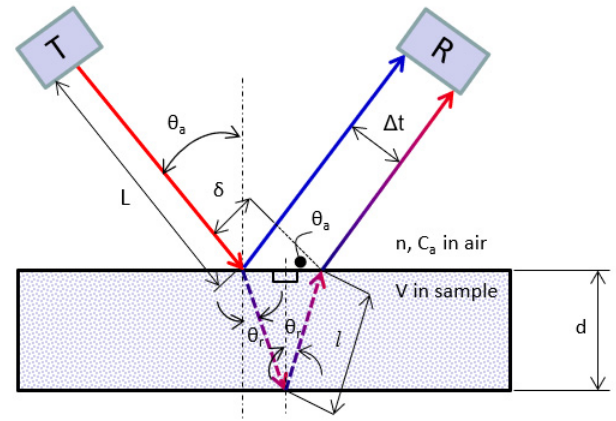
Figure 1. Diagram showing the geometry of the reflection mode [2].